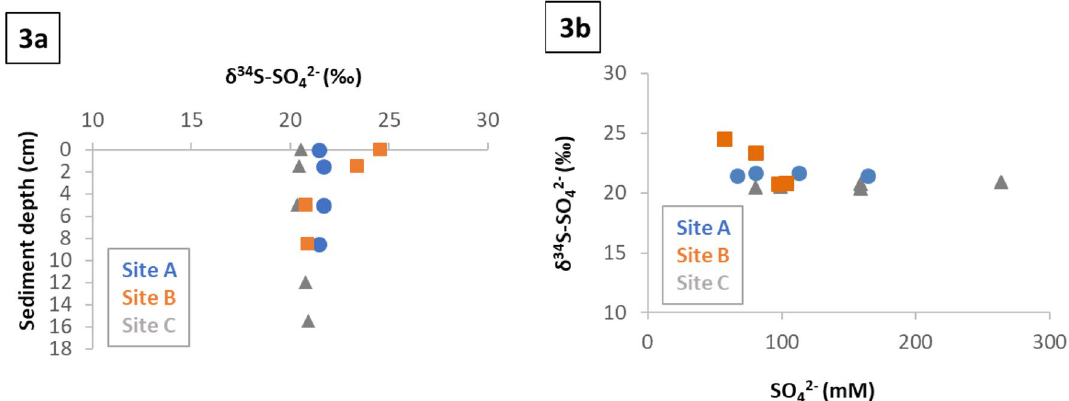
Figure 3. Porewater sulphate isotopic composition. Isotopic signature evolution with depth ( 3a ) and with respect to concentration ( 3b ). Data correspond to June 2021